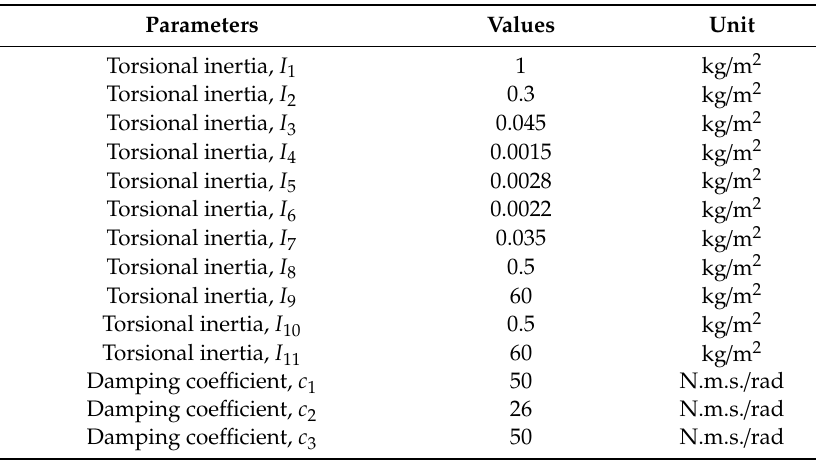
Table A3. Input parameters for the powertrain dynamic